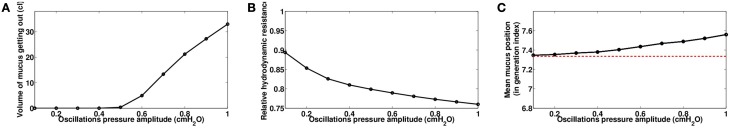
Role of oscillating pressure Po, with Ps = 0.6 cmH2O and f = 20 Hz, data computed at the end of the manipulations for time t = 230s. (A) Volume of mucus getting out of the tree. (B) Relative hydrodynamic resistance of the tree. (C) Mean mucus position in the tree, in generation index. The red dashed line represents the value before the manipulation.